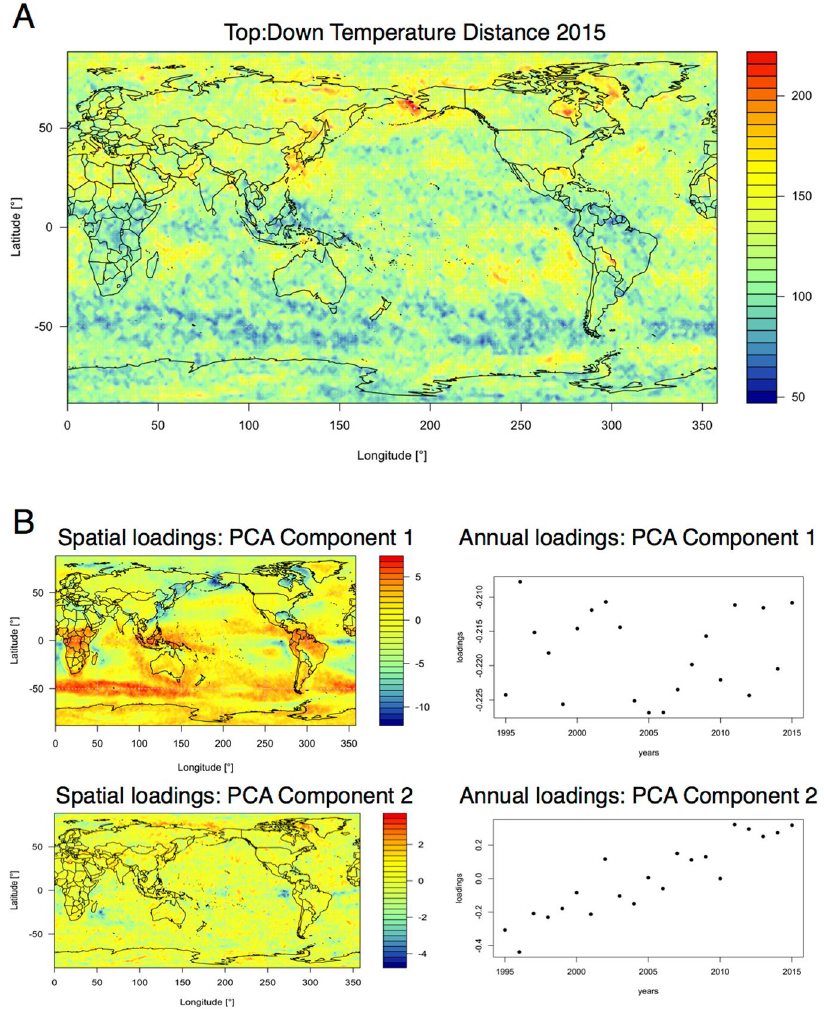
Figure 8. Panel A: Distribution of Top:Down Distance values calculated from yearly temperature time series in 2015, with warmer colors indicating greater difference between top and bottom visibility graphs. Panel B: results of PCA applied to Top:Down Distance maps for the years 1995–2015. The first component accounted for around 40% of the variance with stable yearly loadings. Component two accounted for around 5% of the variance and showed marked changes in yearly loadings over time. Images were built using R software 50,51 with ncdf4 package, code available under